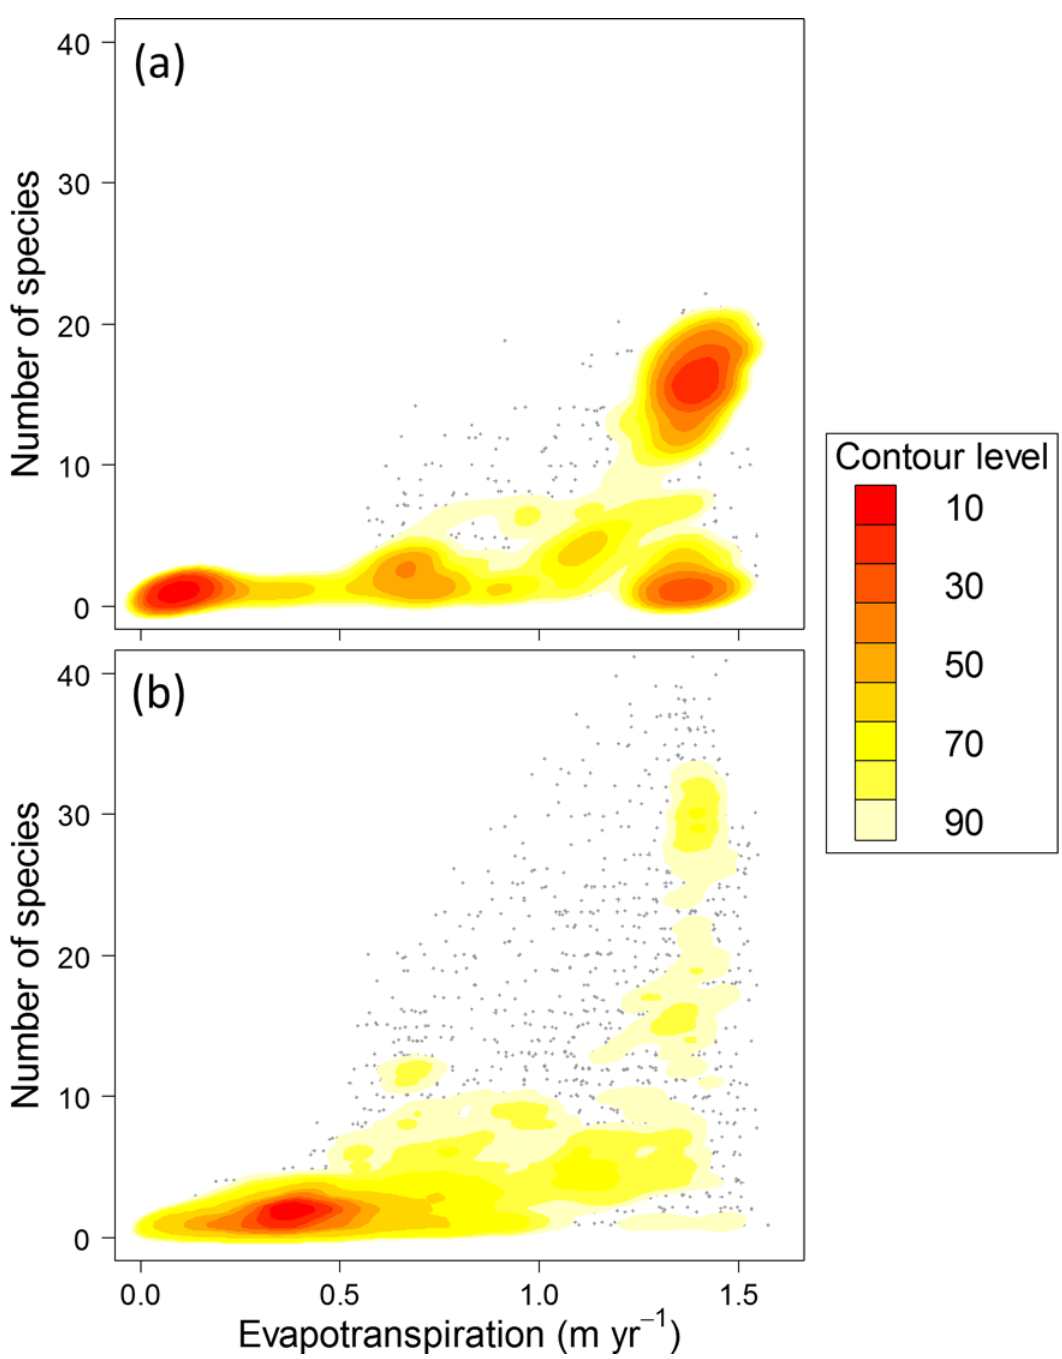
Fig 2. Kernel Density Analysis Of Species Richness For Frugivore Parental Care Type (a) frugivore passerine bird species that display female-only parental care ( n = 109) and (b) frugivore passerine bird species that display other forms of parental care ( n = 452) as a function of evapotranspiration within equal-area hexagon cells of a global icosahedron (spatial resolution = 12,452 km 2 ). The filled contours are kernel density estimates at 10% intervals from 10% to 90%. The intervals correspond to the upper percentages of the highest density regions. The grey points are hexagon cells whose values occur outside the 90% contour interval.